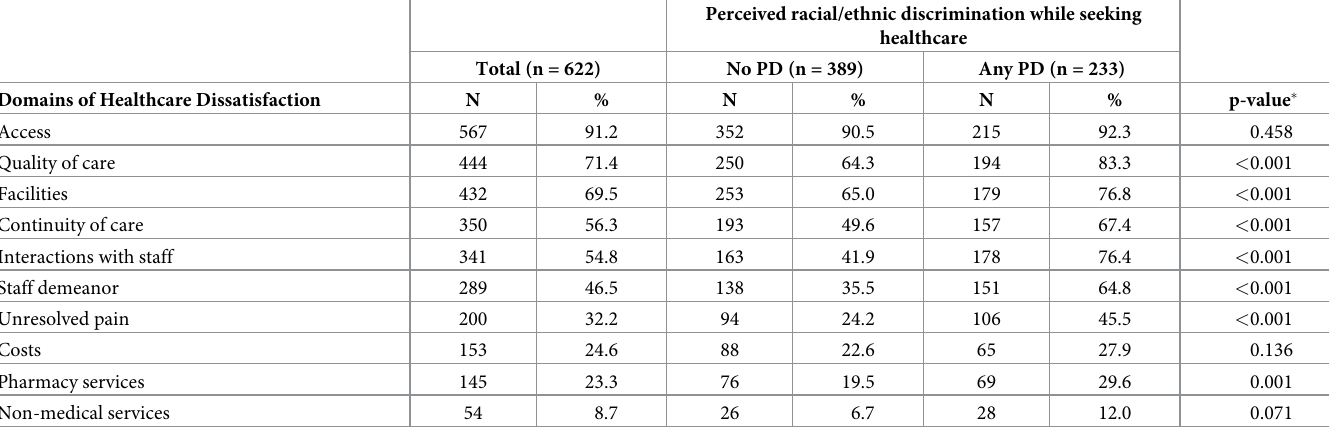
Table 3. Frequency and percentage of domains of dissatisfaction with healthcare experiences, stratified by whether they reported any (vs. no) racial/ethnic-based perceived discrimination while seeking